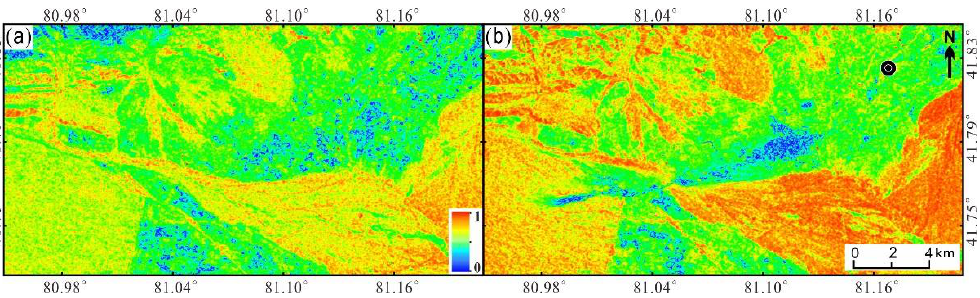
Figure 6. Coherence coefficient diagram. ( a ) Pre-seismic coherence coefficient diagram; ( b ) Coseismic coherence coefficient diagram. Location of the hypocenter, drawn as a black circle.